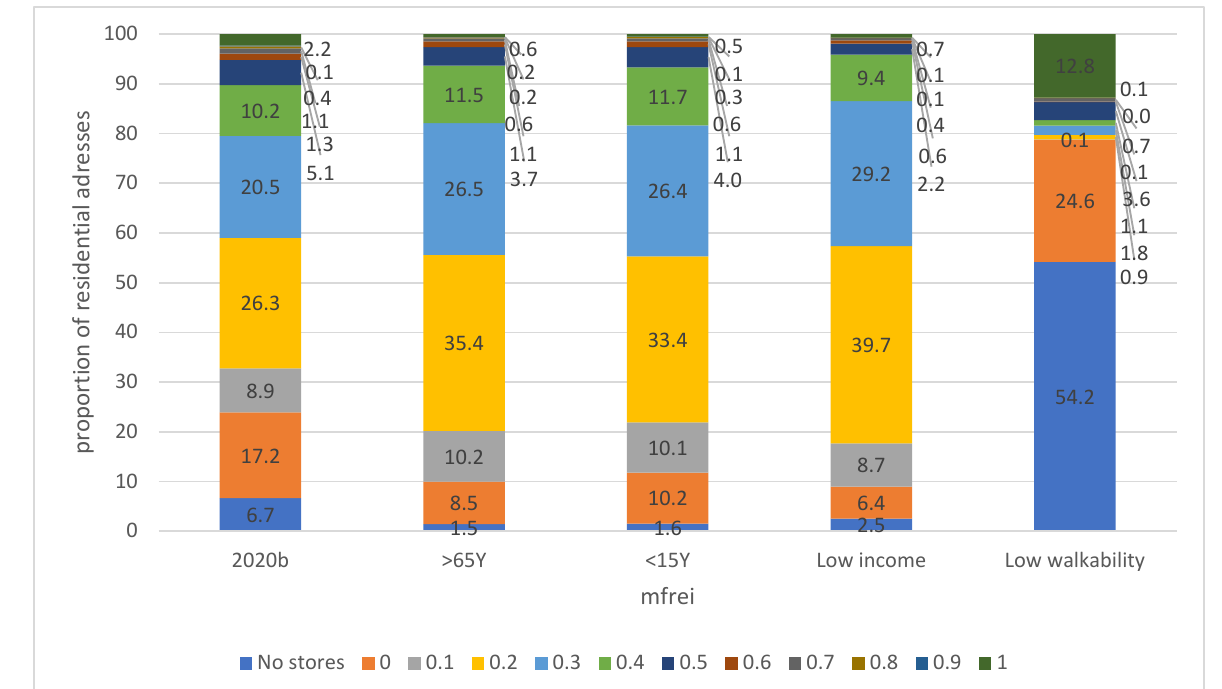
Figure 7. Food swamps in residential areas with a lot of people > 65 years and younger than 15 years; for people with low incomes and regions with low walkability for the year 2020, data includes farmers’ shops and community gardens. 2020b is identical, as in Figure 6, and is added for comparison purposes. The mFREI scores are expressed on a population basis.